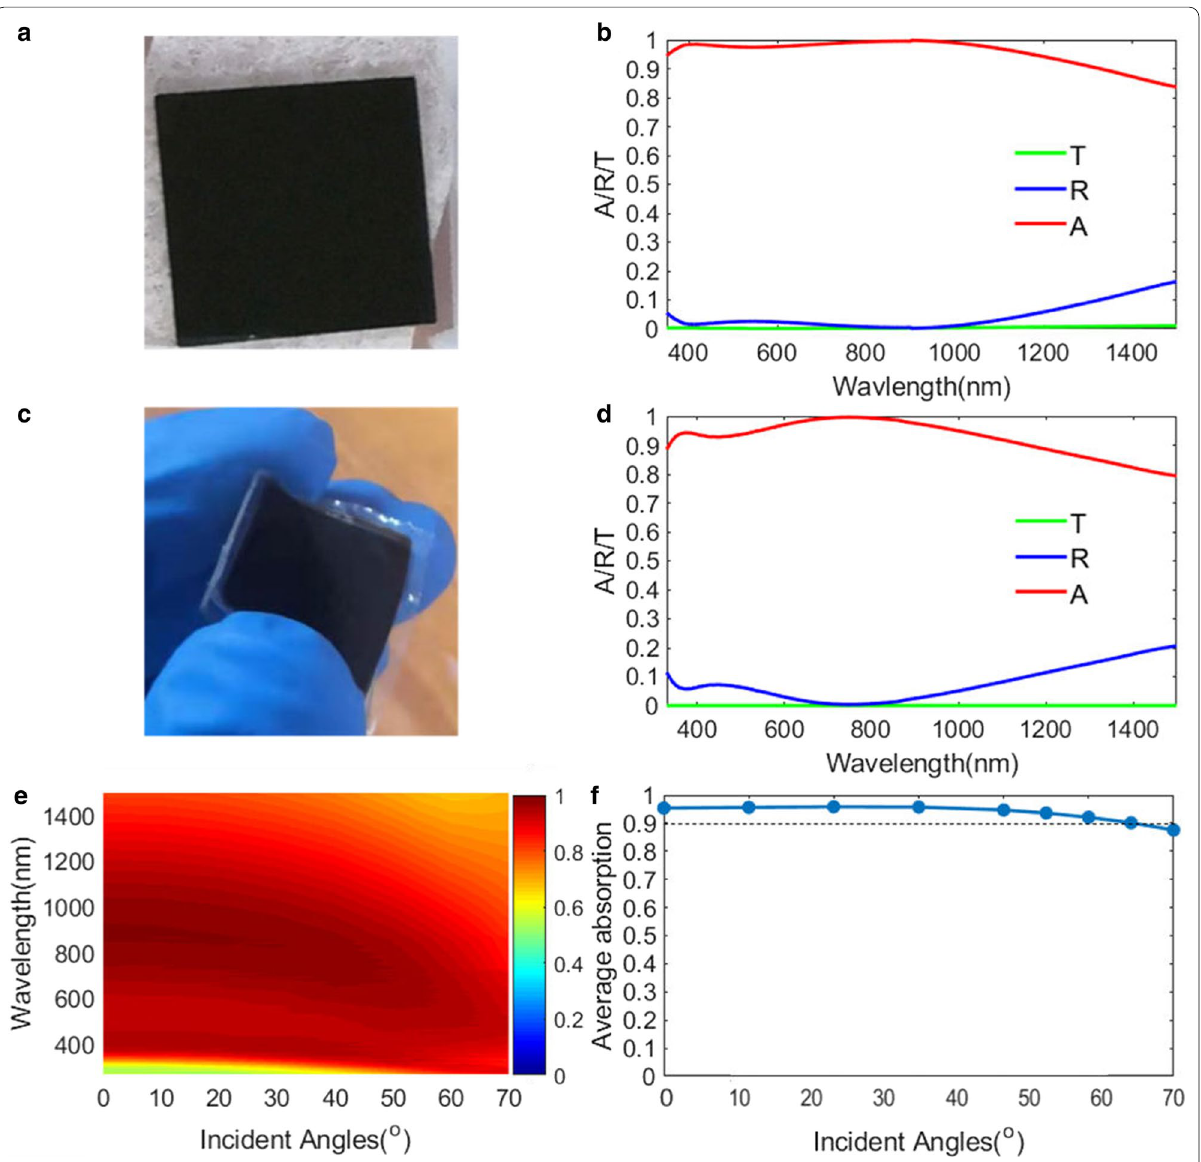
Fig. 4 a Photograph of the metasurface on a glass substrate. b Experimental absorption/transmission/reflection spectra of a metasurface structure. c Photograph of a flexible metasurface on a PE substrate. d Experimental absorption/transmission/reflection spectra of a flexible metasurface. e Experimental angle-dependent absorption spectra of a metasurface absorber under an unpolarized light. f Experimental averaged absorption at wavelengths ranging from 350 to 1000 nm at various incident angles from 0° to 70°of a unpolarized